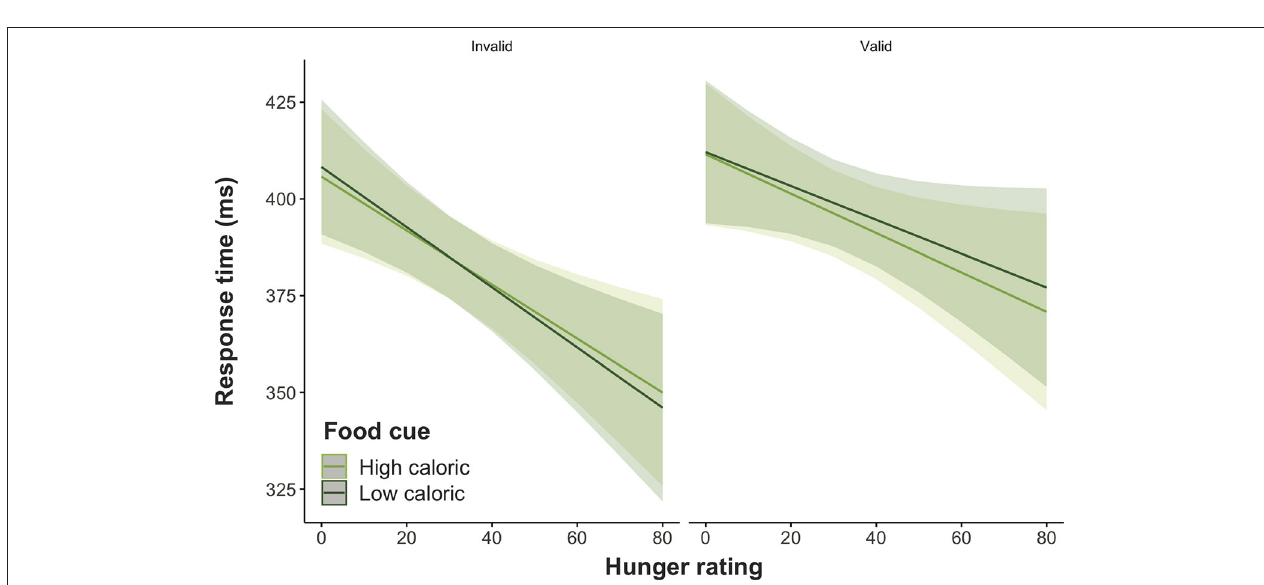
FIGURE 5 | Predicted marginal effects of attentional engagement and disengagement on response times as a function of hunger ratings and food